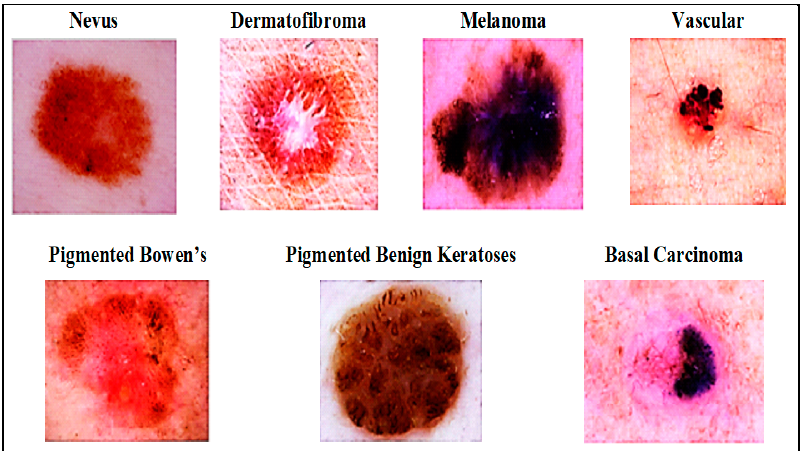
Figure 2. Skin disease categories from International Skin Imaging Collaboration (ISIC) dataset [12].